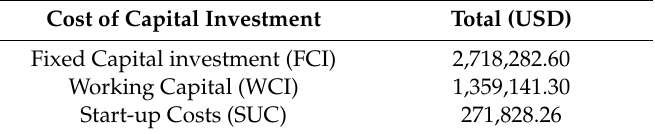
Table 4. Total capital investment for the mass integrated approach for shrimp